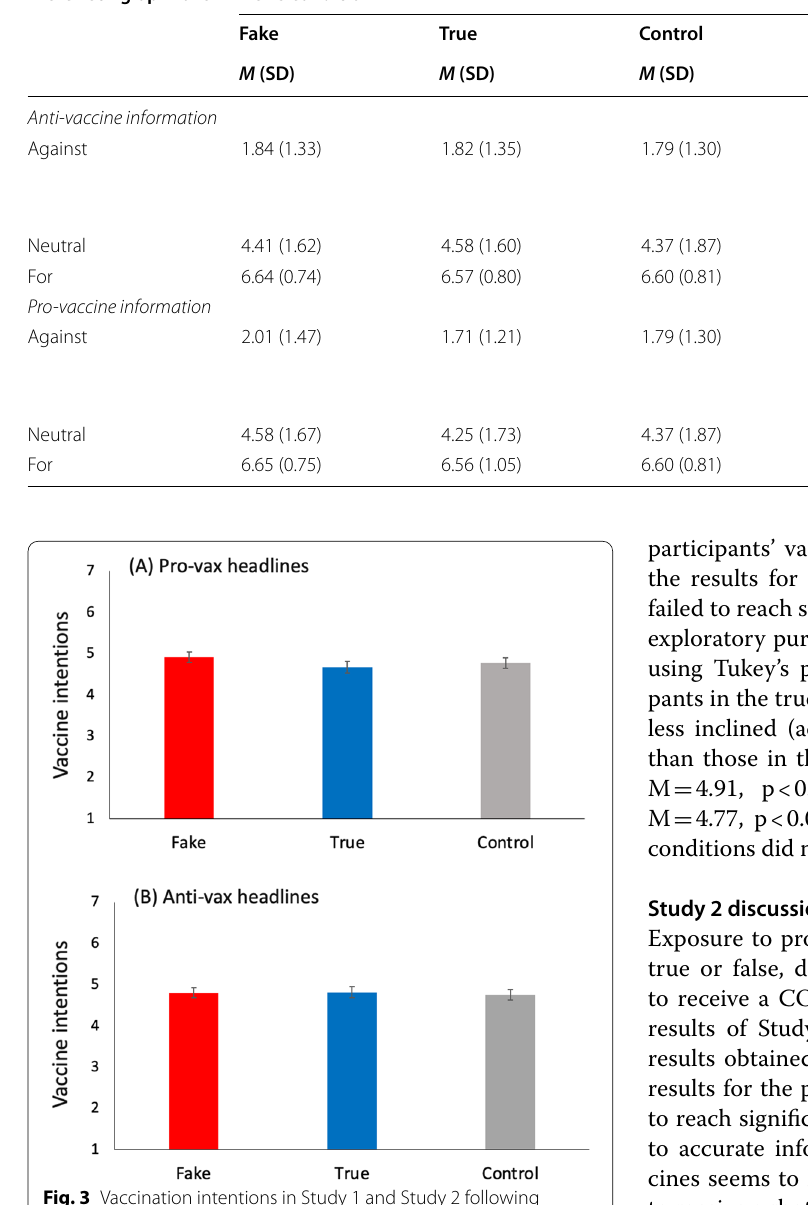
other behavioural intentions are presented in Additional file 1: Table S4 in the supplementary materials. Being exposed to anti-vaccine headlines, whether accurate or not, yielded no significant effect on the